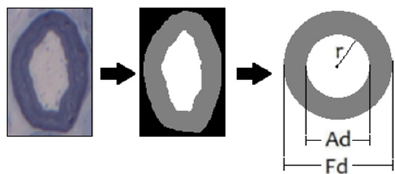
Figure 3 . The axon shapes were assumed to be circular. The calculated areas of the axons and myelinated axons from the segmented image were equated to the area of a circle to find the axonal diameter (Ad) and the myelinated fiber diameter (Fd).